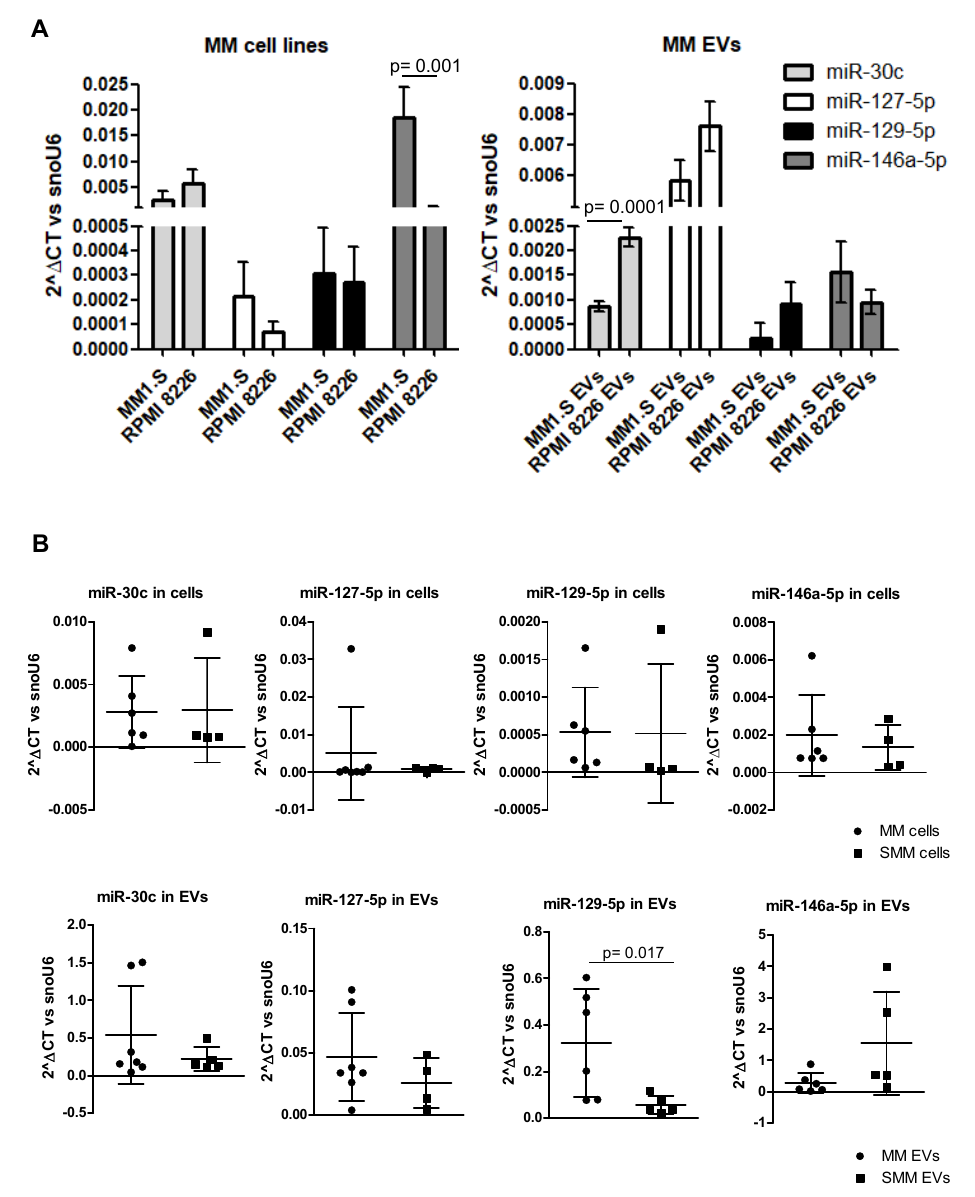
Figure 3. ( A ) Real-time PCR analyses for miR-30c, miR-127-5p, miR-129-5p and miR-146a-5p was performed on MM1.S and RPMI 8226 cells and EVs. The statistical significance of the di ff erences was analyzed using a two-tailed Student’s t -test. ( B ) Real-time PCR analysis for miR-30c, miR-127-5p, miR-129-5p and miR-146a-5p was performed on cells and EVs from the bone marrow aspirates of MM patients (n = 6to7) and SMM patients (n = 4to5). Values are plotted as 2ˆ ∆ Ct versus snoU6. The statistical significance of the di ff erences was analyzed using Mann-Whitney